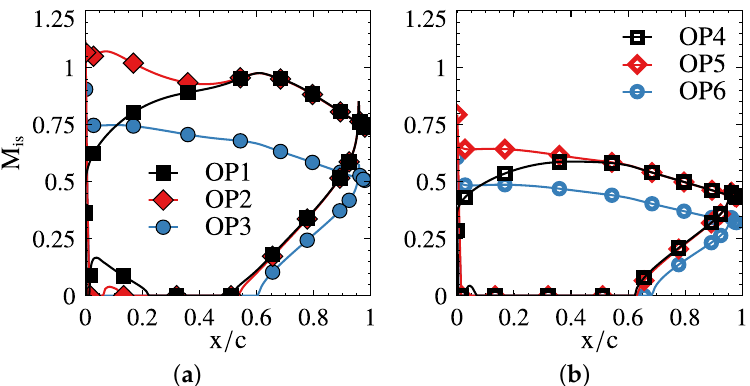
Figure 11. Isentropic Mach number distribution on the airfoil at the different OP considered. ( a ): OP1-3, ( b ): OP4-6.